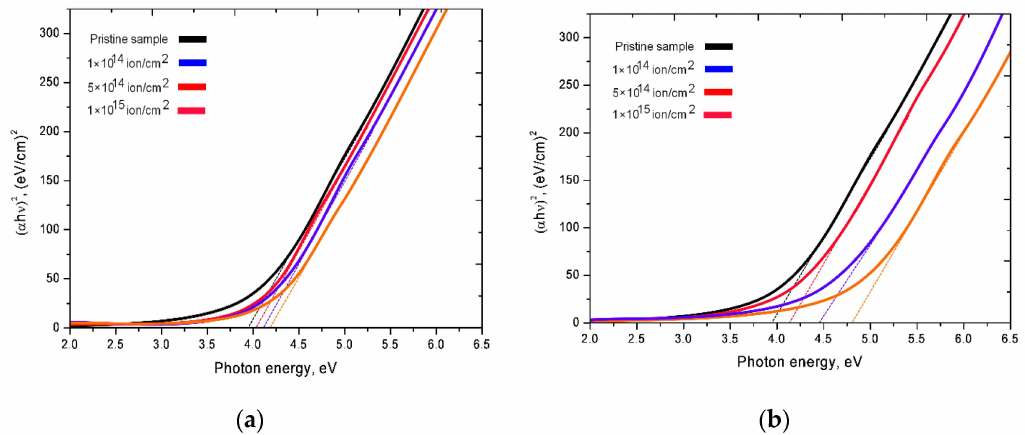
Figure 5. Tauc’s plot obtained from UV-vis transmittance spectra for evaluating the optical band gap of AlN: ( a ) Kr 15 + ion irradiated dose; ( b ) Xe 22 + ion irradiated dose.